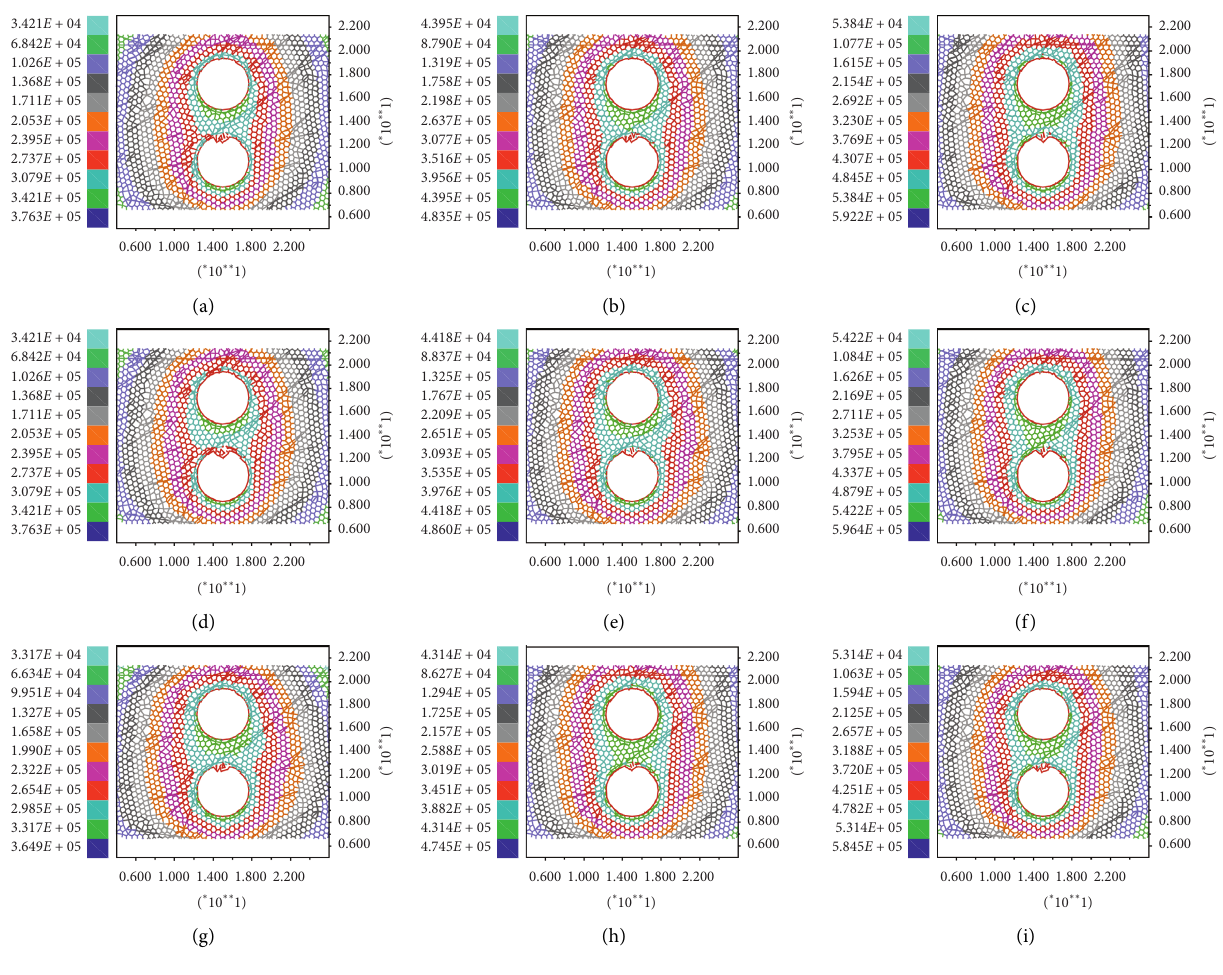
Figure 5: Pore pressure